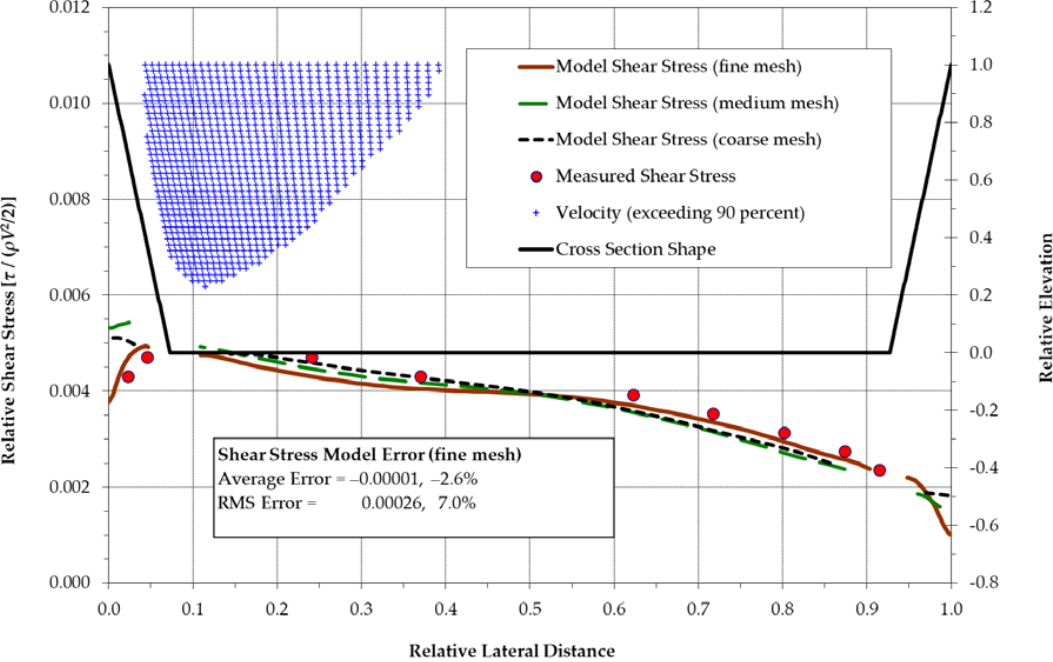
Figure 15. Comparison of simulated and measured shear stress for cross-section CIIO (upstream entrance to second channel curve). The channel cross section is also plotted along with the location of greatest velocity (within 90% percent of maximum velocity).